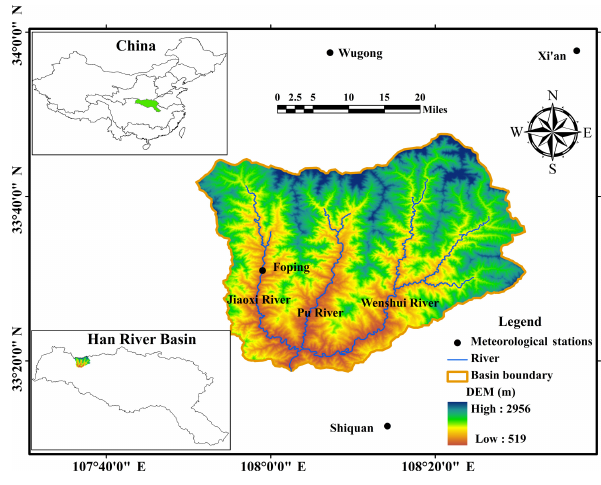
Figure 1. The location of the meteorological stations and the river network of Ziwu